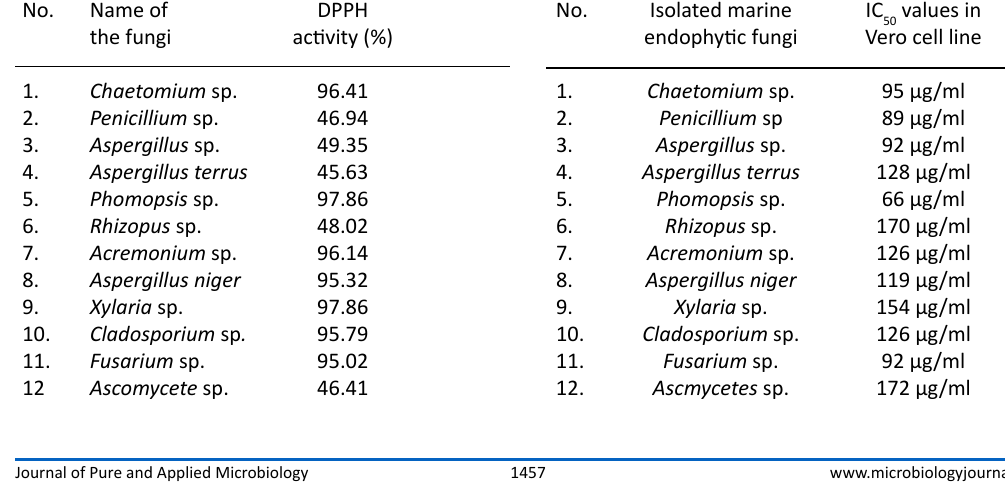
Table 4. Antioxidant activity of crude endophytic fungal Ethyl acetate extract using the DPPH Assay method No.